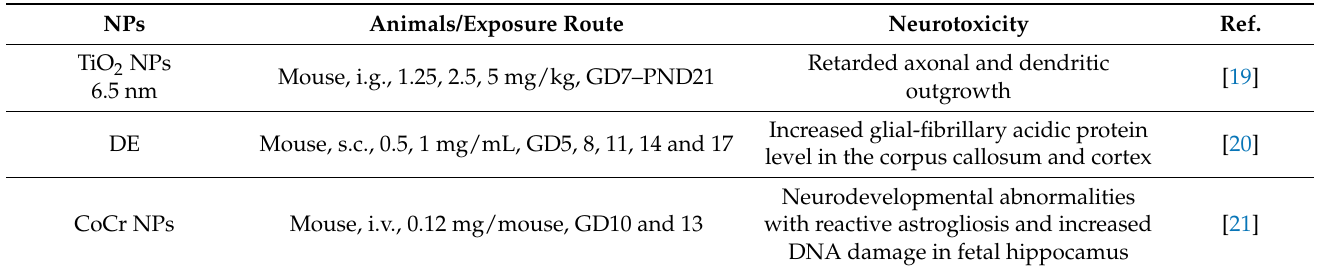
Retarded axonal and dendritic outgrowth Increased glial-fibrillary acidic protein level in the corpus callosum and cortex Neurodevelopmental abnormalities with reactive astrogliosis and increased DNA damage in fetal